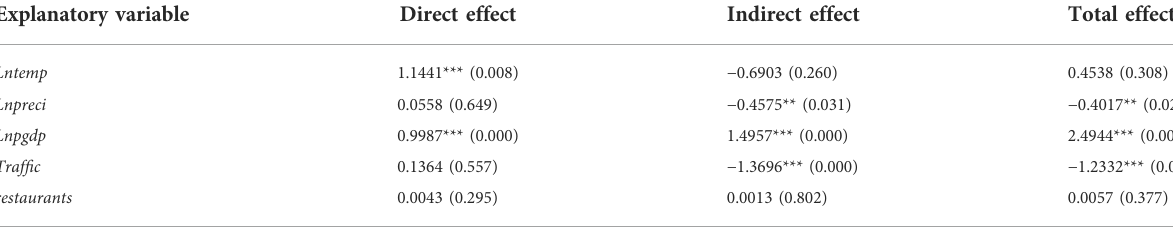
TABLE 5 Direct and indirect effects of explanatory variables on inbound overnight